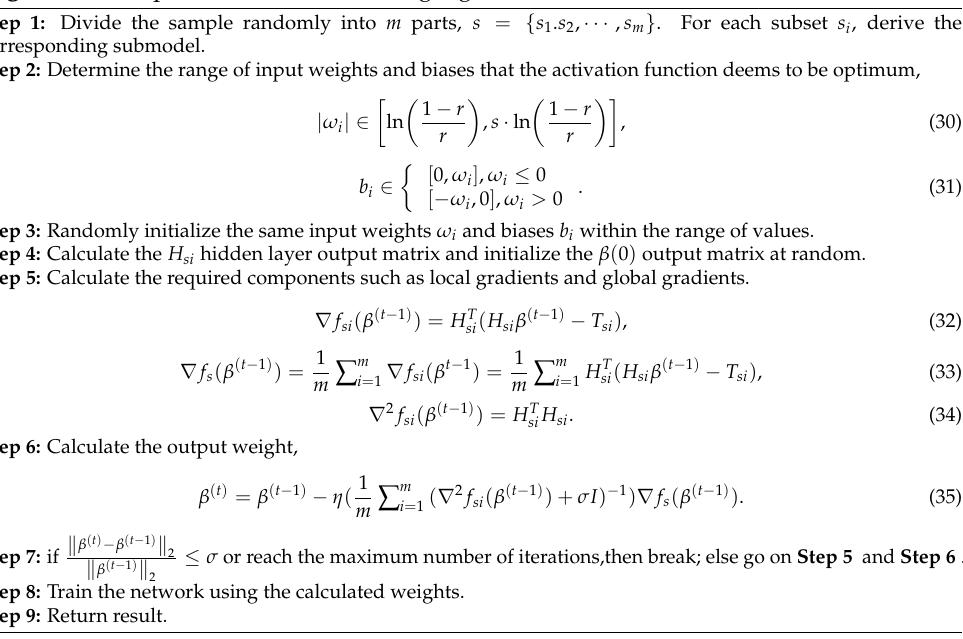
Algorithm 1 Improved FNNRW learning